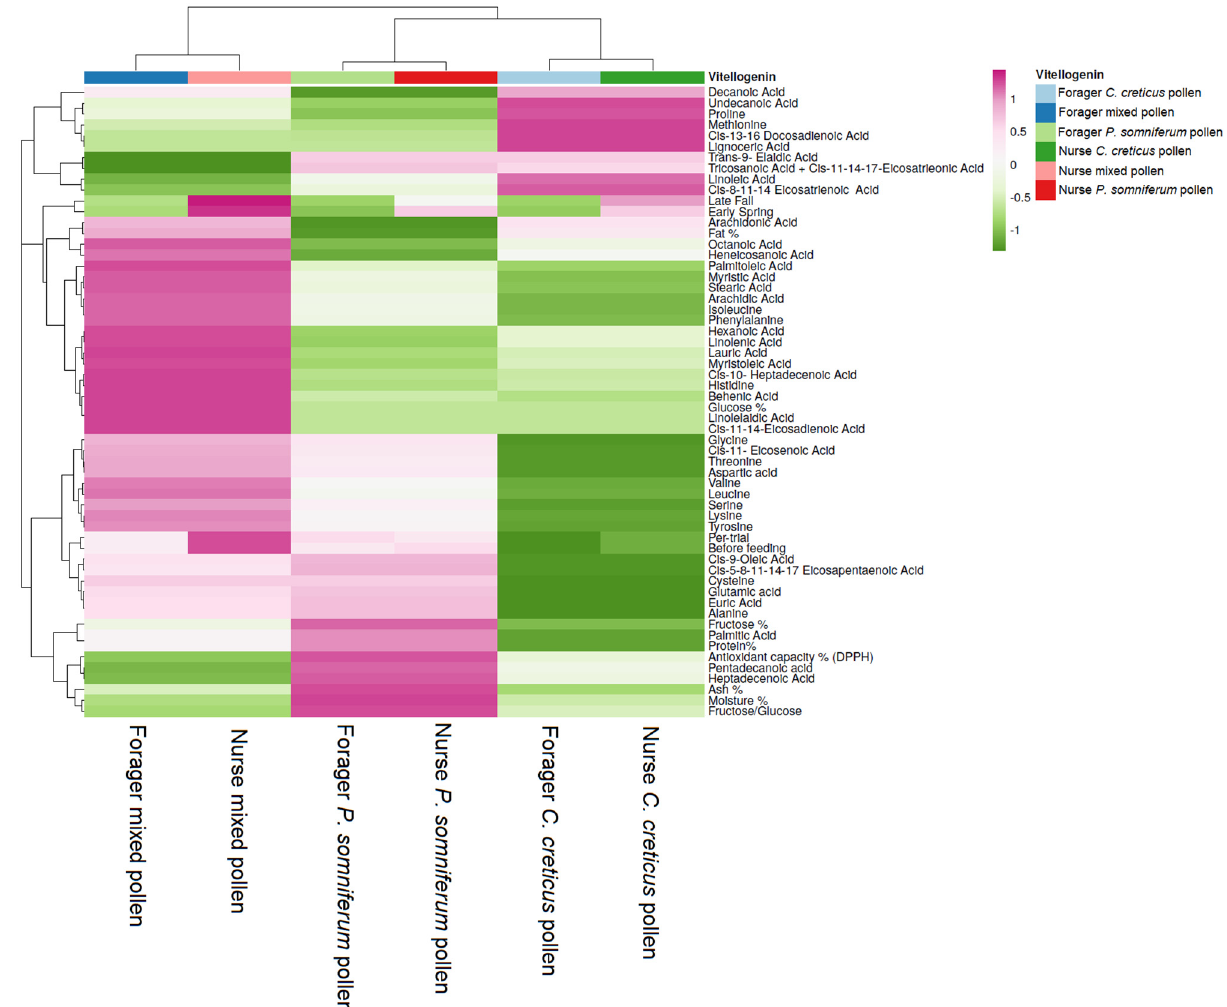
Figure 5. Hierarchical clustering and heatmap visualization of the Vg content present in forager and nurse bees based on the fatty and amino acid profiles of feeding product types. Columns indicate the product types fed to foragers and nurse bees and rows the products’ fatty acid and amino acid patterns along with the content in Vg in different periods. Cells are colored based on the quantity of Vg in each forager and nurse bee, where pink represents a strong positive correlation and green a strongly negative correlation. The row dendrogram resulted from the correlation between the fatty and amino acid profiles and Vg level in different feeding periods; the column dendrogram shows the correlation between foragers and nurse bees and feeding product types.